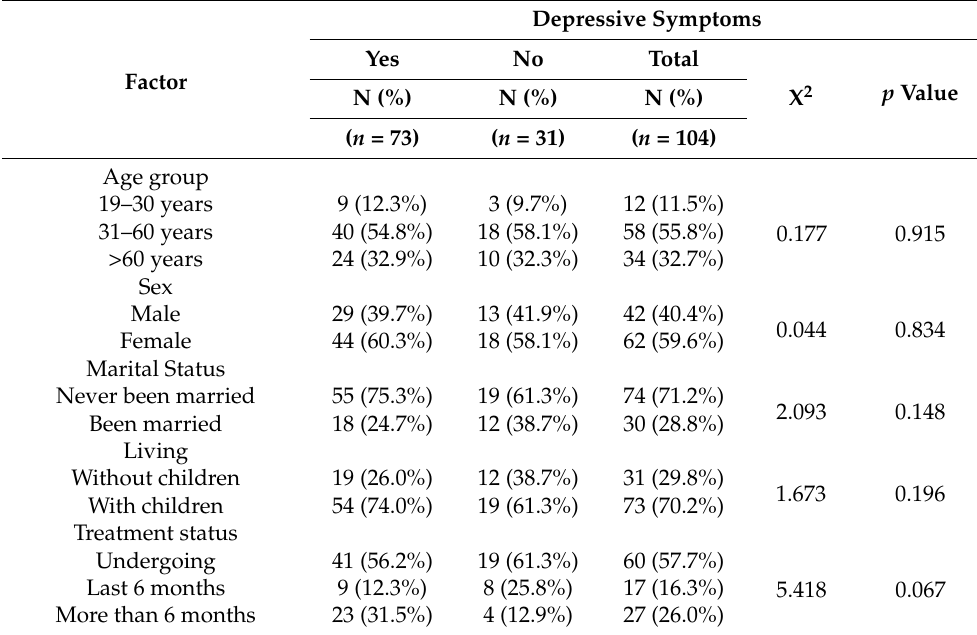
Table 2. Relationship between depression and cancer patient sociodemographic characteristics and treatment plans ( n =